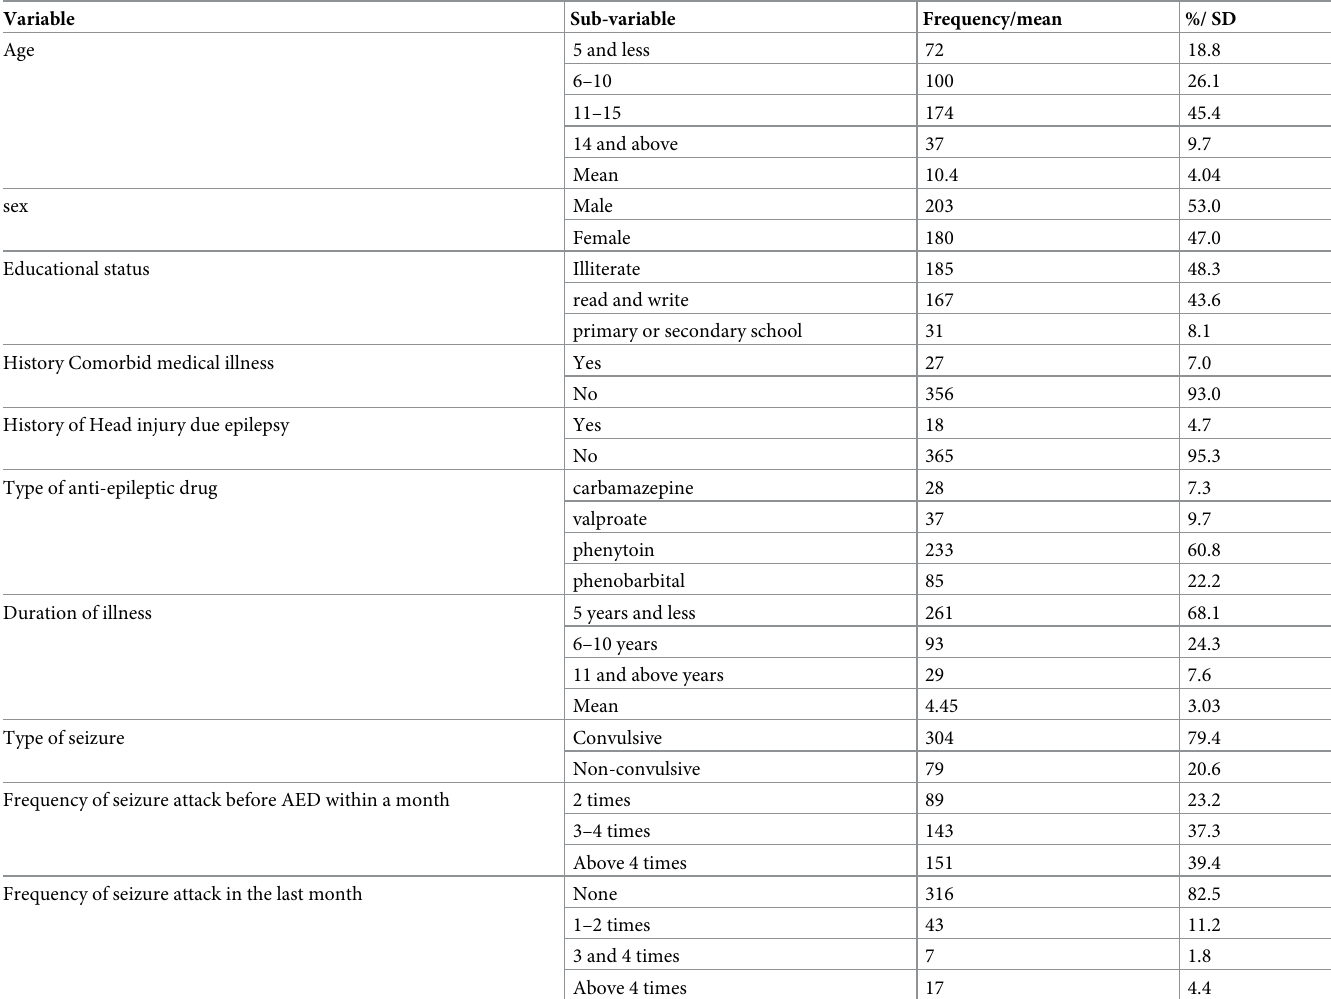
Table 2. Socio-demographic characteristics of children and adolescents with epilepsy in selected three hospitals of Amhara region, Ethiopia.